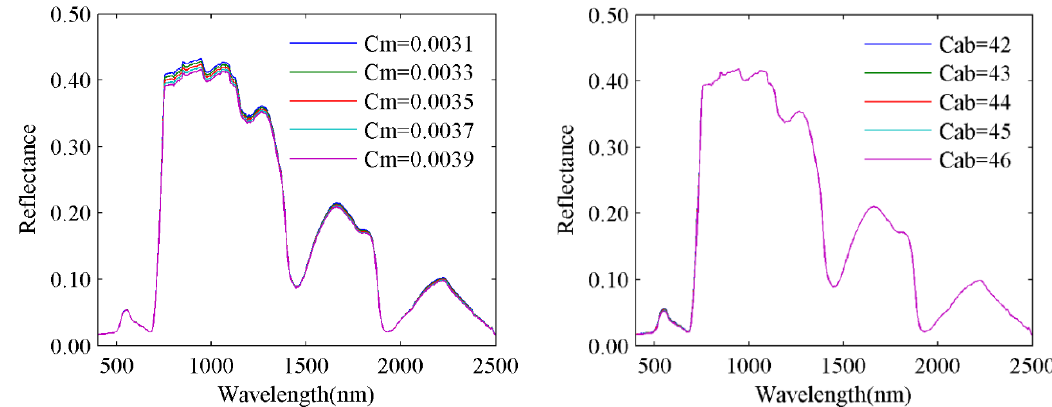
Figure 9. INFORM generated forest reflectance spectra (0.4–2.5 µm) for different values of stem density, crown diameter, LAI, height, dry matter content and leaf chlorophyll